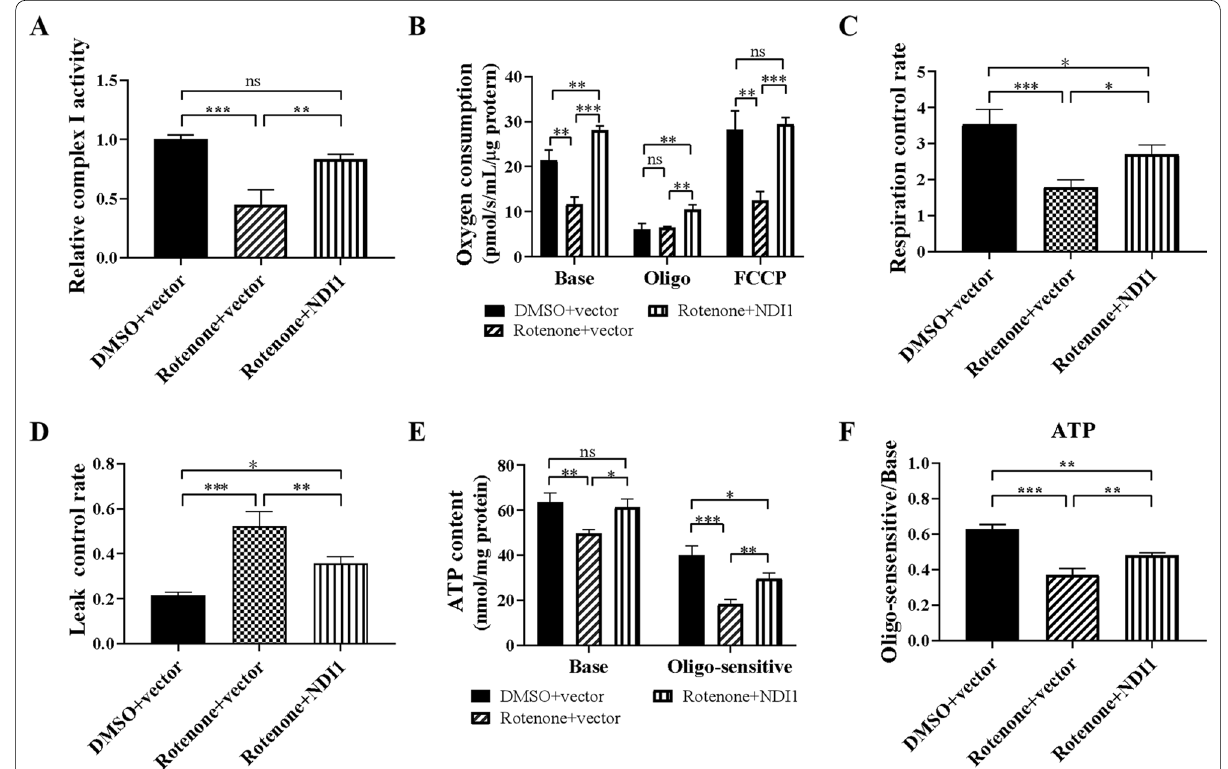
Fig. 3 The mitochondrial oxidative phosphorylation function in rotenone-induced PD cell model transduced with NDI1. A The mitochondrial complex I enzyme activity was determined by measuring the NADH oxidation rate using a spectrophotometer. B The basal oxygen consumption (Base), ATP synthase uncoupling oxygen consumption after oligomycin treatment (Oligo), and maximum oxygen consumption after FCCP treatment (FCCP) were detected using a cellular respiration apparatus. C RCRs (respiratory control rates) were calculated as Base /Oligo. D LCRs (leakage control rates) were calculated as Oligo/FCCP. E The basal ATP content (Base) and oligomycin-sensitive ATP content (Oligo-sensitive) were measured using a luciferin/luciferase chemiluminescence ATP assay kit. F The ratios of oligomycin-sensitive ATP content were calculated as Oligo-sensitive/ Base. Rotenone vector group compared with DMSO vector group, or Rotenone NDI1 group compared with + + + Rotenone vector group, or Rotenone NDI1 group compared with DMSO vector group, ns not significant. * P < 0.05, ** P < 0.01, *** P < + + +